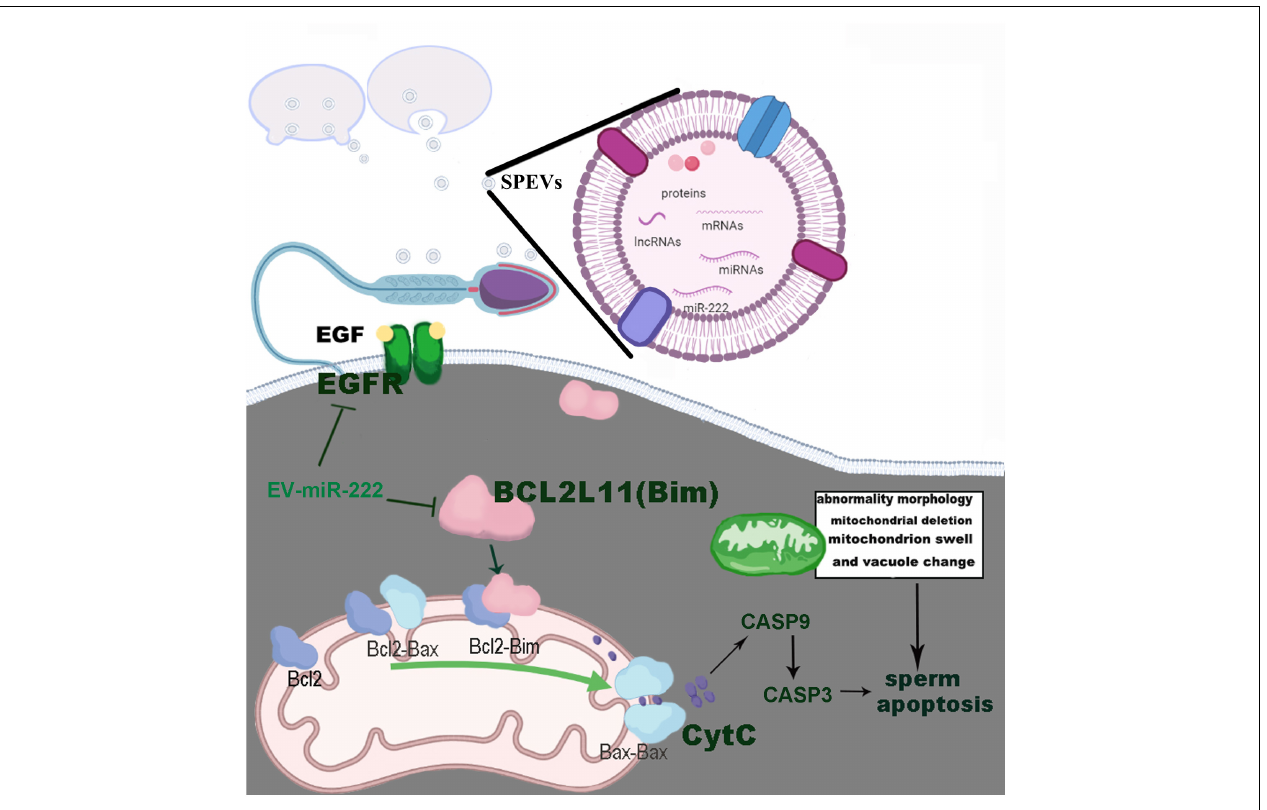
FIGURE 7 | Pathways by which EV-miR-222 regulates apoptosis of porcine